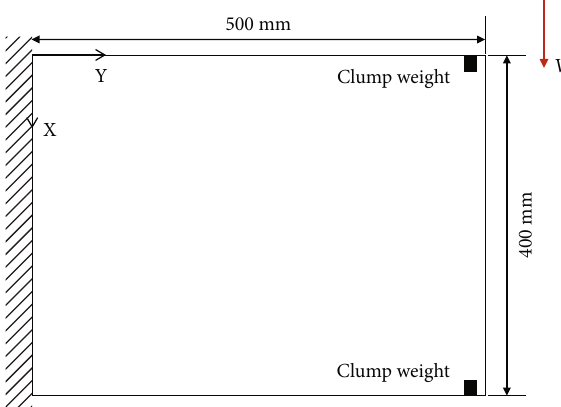
Figure 7: Fixed-root aluminum